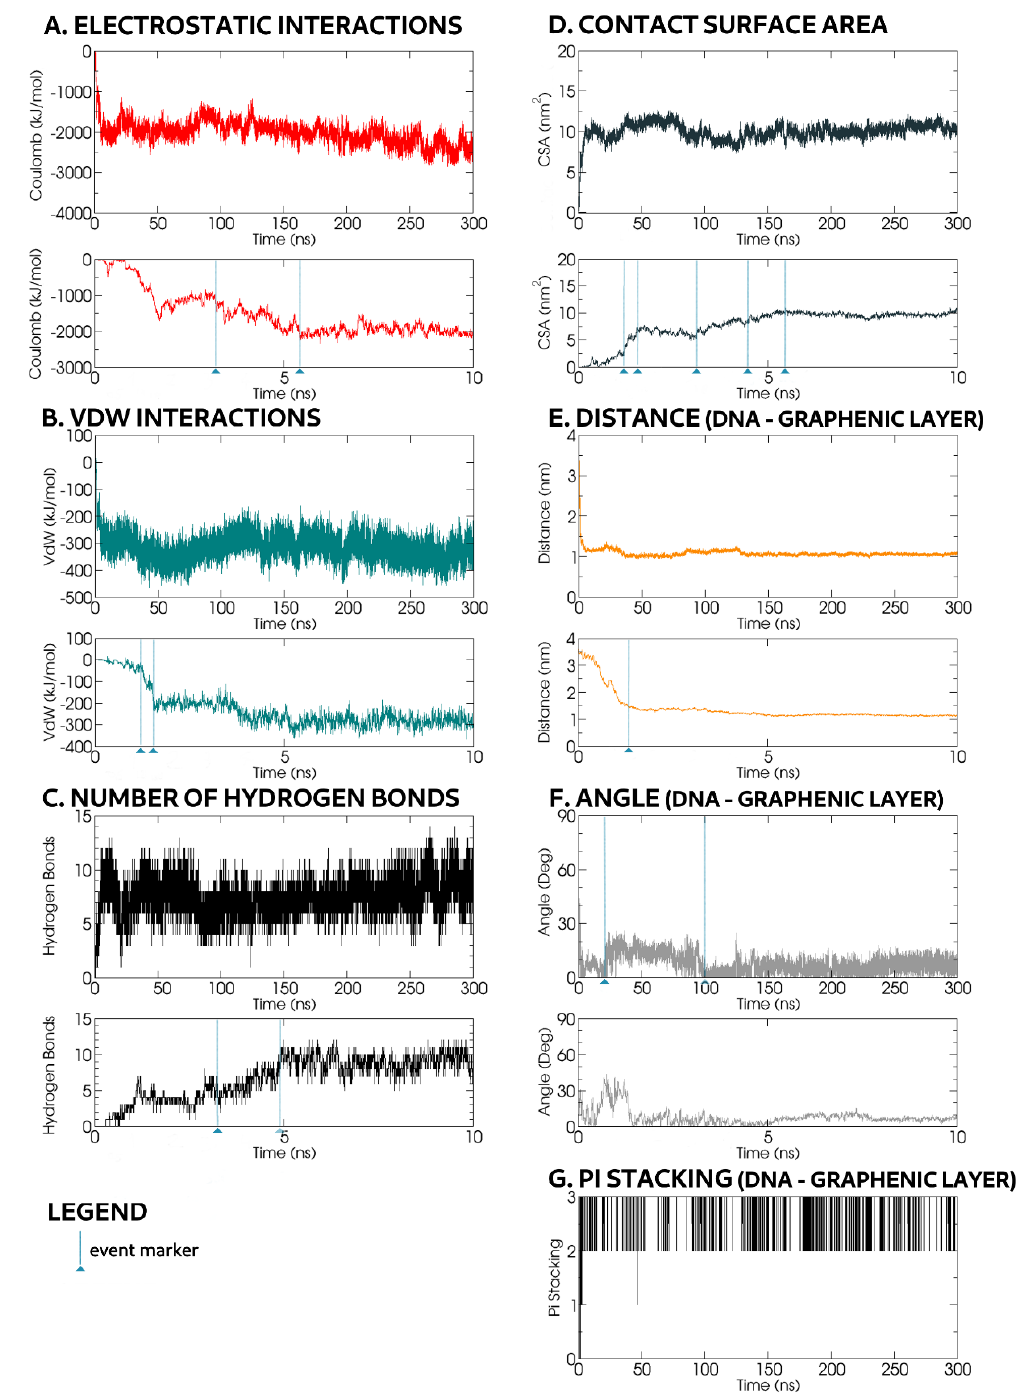
Figure 10. Evolution of different parameters over the 300 ns simulation time: ( A ) Electrostatic interactions between rGO and ssDNA; ( B ) VdW interactions between rGO and ssDNA; ( C ) Hydrogen bonds formed between rGO and ssDNA; ( D ) Contact surface area between rGO and ssDNA; ( E ) Distance between the ssDNA molecule and the graphenic layer; ( F ) Angle between the ssDNA molecule and the graphenic layer; ( G ) π–π stacking between ssDNA and the graphenic layer.